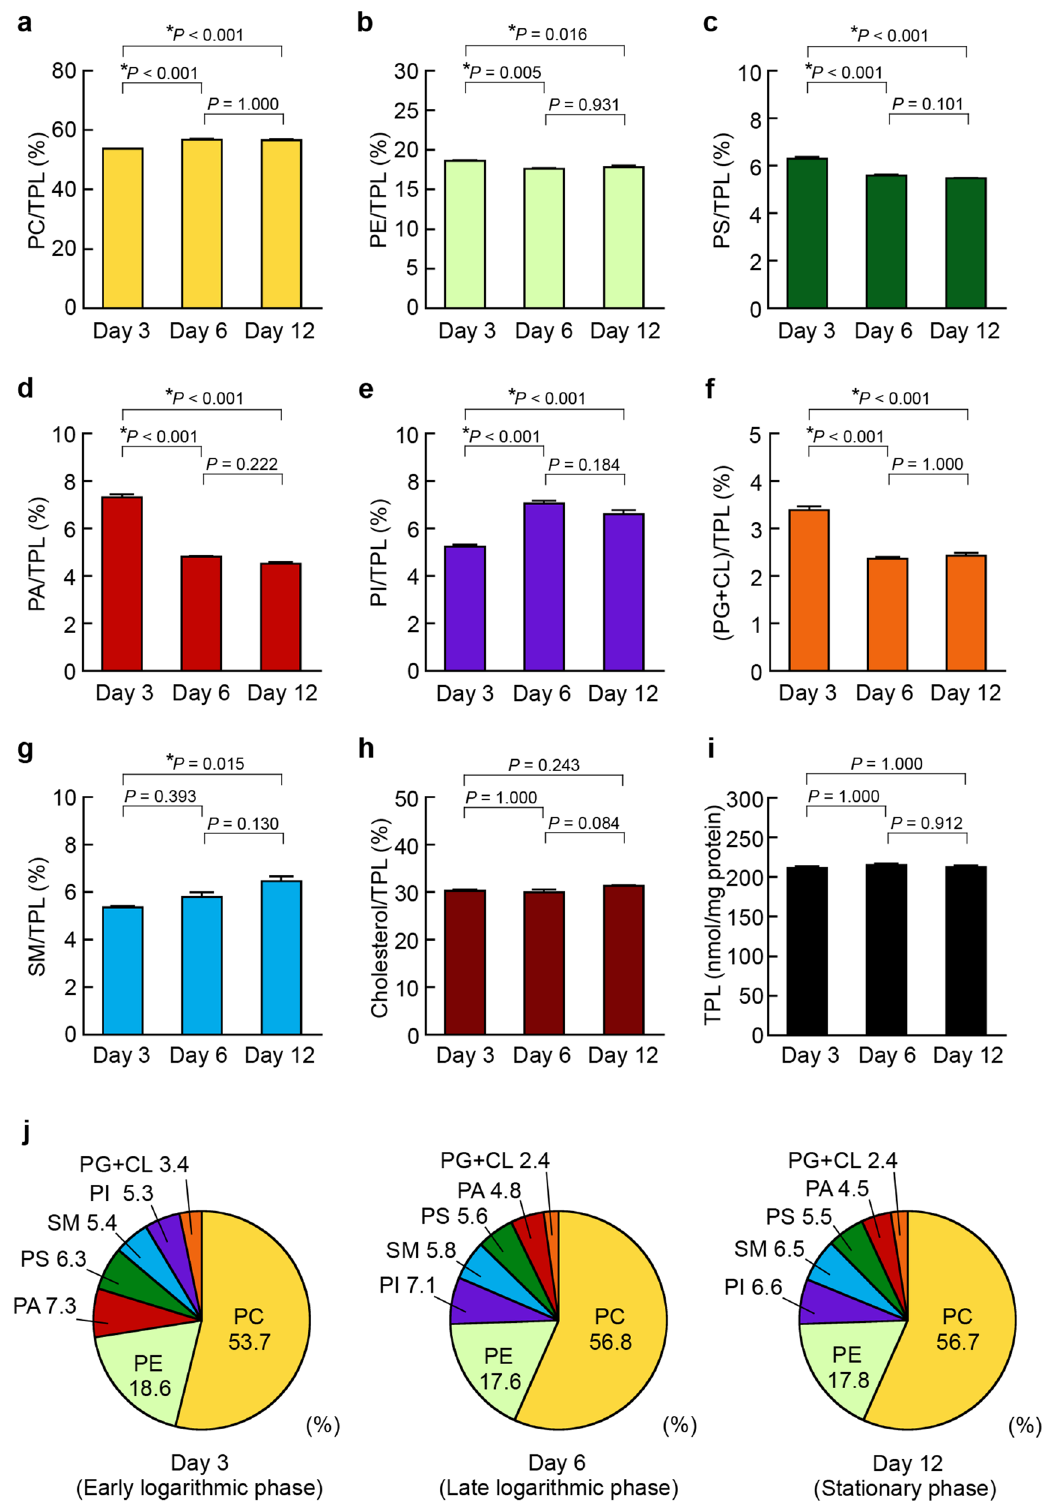
Figure 2. Alteration of phospholipid composition in HepG2 cells. HepG2 cells were seeded at a density of 5.0 × 10 4 cells/cm 2 in 75-cm 2 flasks and cultured in DMEM containing 10% FBS at 37 °C for the indicated days. At Day 3 (early logarithmic phase), Day 6 (late logarithmic phase) and Day 12 (stationary phase), cellular lipids were extracted. The contents of PC, PE, PS, PA, PI, PG + CL, SM and cholesterol in HepG2 cells were determined by the enzymatic measurements and protein assay (see Supplementary Table S1). The ratios of PC/TPL ( a ), PE/TPL ( b ), PS/TPL ( c ), PA/TPL ( d ), PI/TPL ( e ), (PG + CL)/TPL ( f ), SM/TPL ( g ) and cholesterol/TPL ( h ) at Day 3, Day 6 and Day 12 were evaluated. The total phospholipid (TPL) content ( i ) was calculated as the sum of PC, PE, PS, PA, PI, PG + CL and SM contents (mean ± S.E., n = 3, * P < 0.05, significantly different among Day 3, Day 6 and Day 12, one-way ANOVA followed by the Bonferroni test). ( j ) The phospholipid compositions in HepG2 cells at Day 3, Day 6 and Day 12 are shown as pie